Question: Name the type of graph shown.
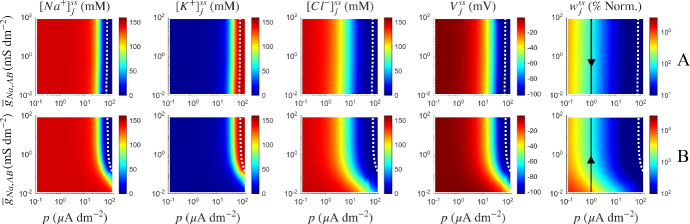
Answer: heatmap